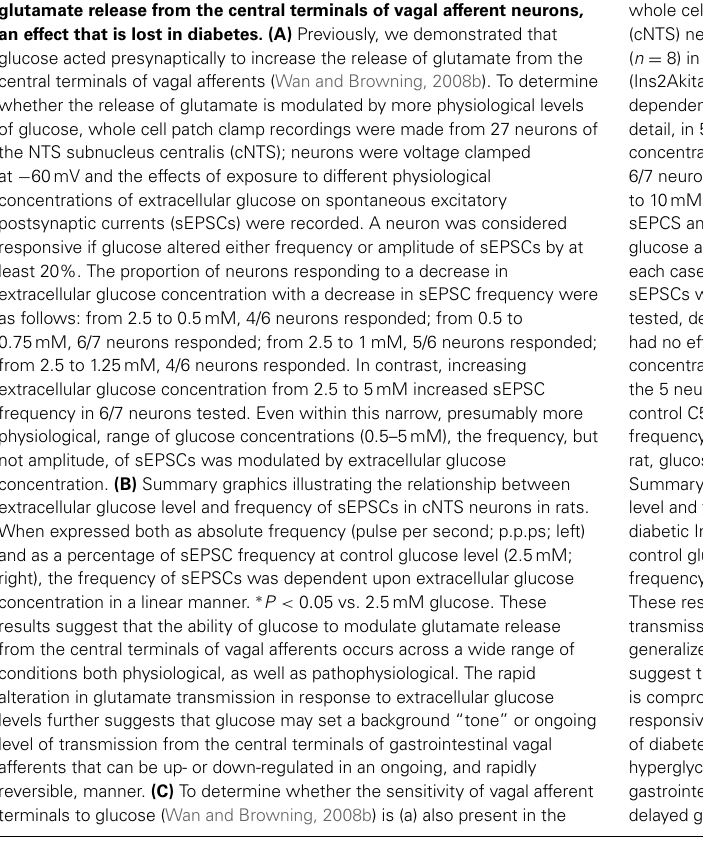
FIGURE 1 | Physiological extracellular glucose levels modulate glutamate release from the central terminals of vagal afferent neurons, an effect that is lost in diabetes. (A) Previously, we demonstrated that glucose acted presynaptically to increase the release of glutamate from the central terminals of vagal afferents (Wan and Browning, 2008b). To determine whether the release of glutamate is modulated by more physiological levels of glucose, whole cell patch clamp recordings were made from 27 neurons of the NTS subnucleus centralis (cNTS); neurons were voltage clamped at − 60mV and the effects of exposure to different physiological concentrations of extracellular glucose on spontaneous excitatory postsynaptic currents (sEPSCs) were recorded. A neuron was considered responsive if glucose altered either frequency or amplitude of sEPSCs by at least 20%. The proportion of neurons responding to a decrease in extracellular glucose concentration with a decrease in sEPSC frequency were